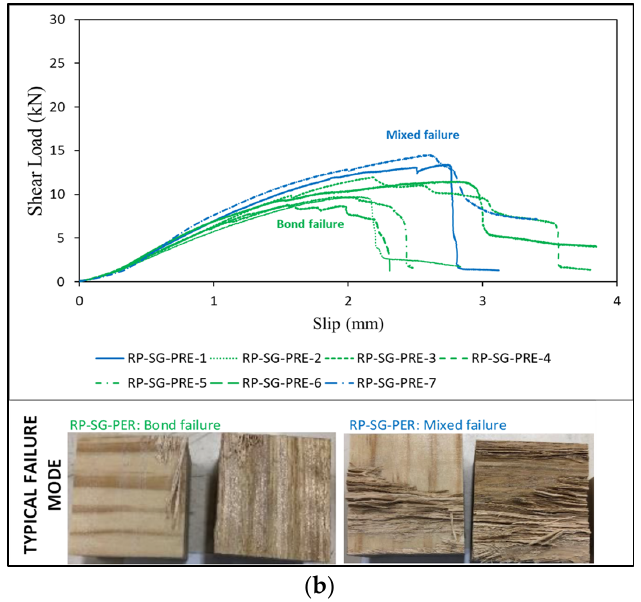
Figure 6. Loading curves and typical modes for RP–SG samples. ( a ) RP–SG–PAL, ( b ) RP–SG–PER.